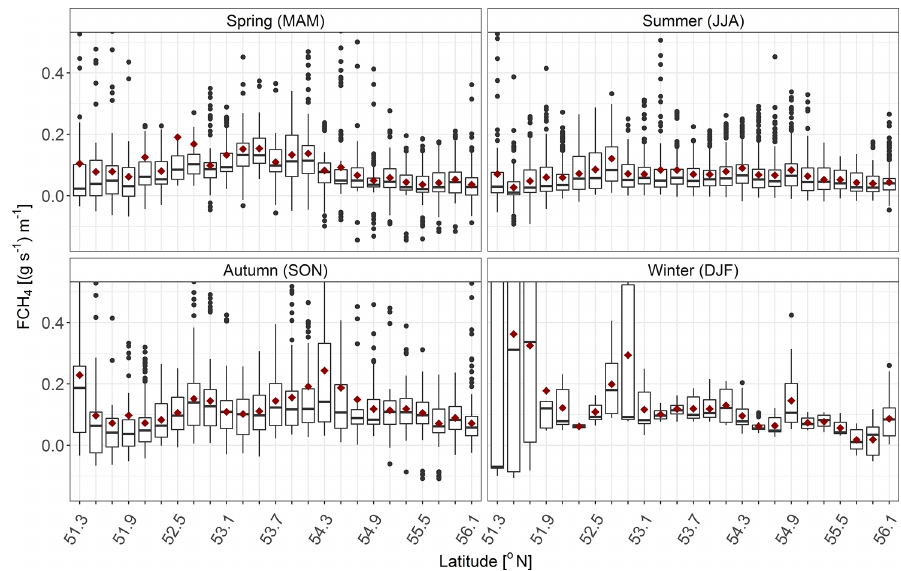
Figure 7. Box and whisker plots of 5min binned averages of CH 4 fluxes along the route of the ferry (latitude bin width: 0.2 ◦ ). The horizontal bar within each box corresponds to the median for a given latitude bin, the upper and lower hinges represent the 75th and 25th quantiles, respectively, and the upper and lower whiskers indicate the largest–smallest observation less–greater than or equal to upper–lower hinge ± 1 . 5 ∗ IQR (inter-quantile range), respectively. The outliers are represented by solid circles and arithmetic means by red diamonds. The flux is integrated over the height of the planetary boundary layer and expressed in units of mass flux per metre travelled crosswind within each latitude bin per unit time.